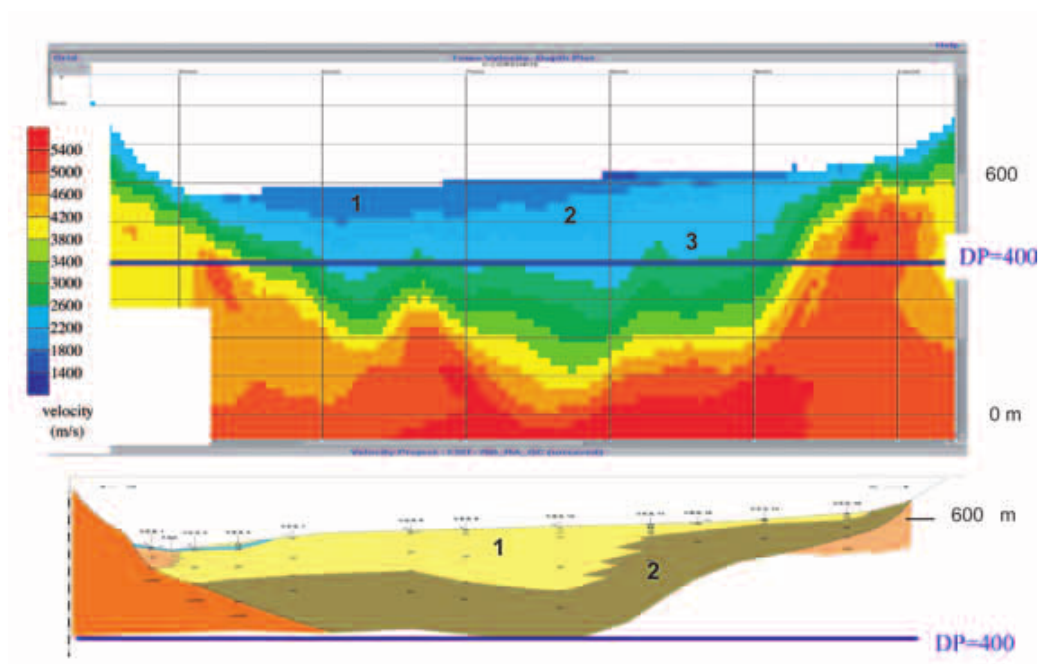
Fig. 12. HR resistivity versus